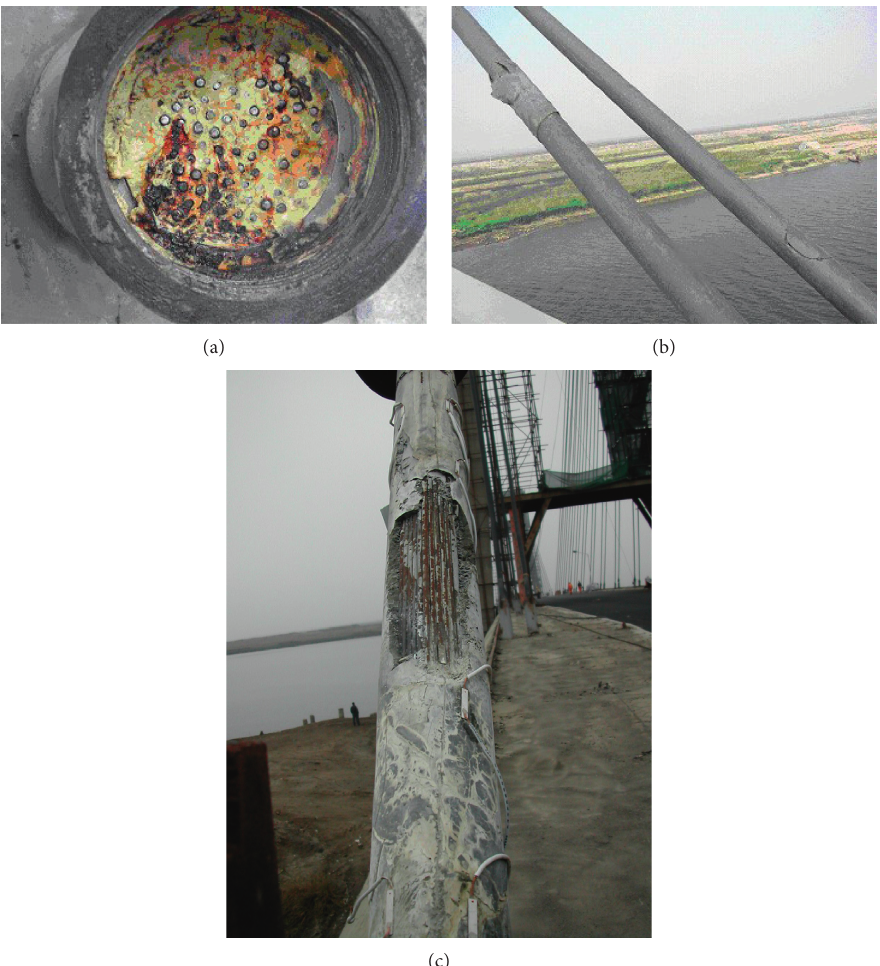
Figure 5: Typical defects of cable stays in Yonghe Bridge: (a) corrosion at end plate of one socket with wire button ends; (b) PE sheathing split; (c) corrosion of wires after cutting PE sheathing for the purpose of creating inspection